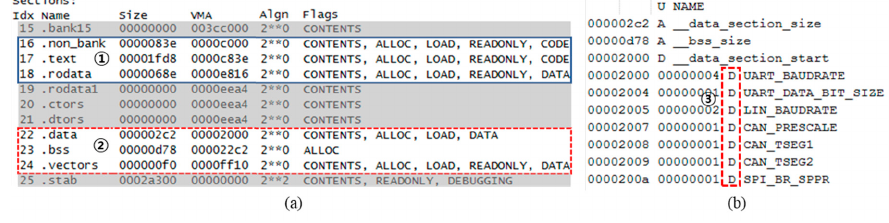
Figure 5. Memory section table and symbol List: ( a ) Memory section table; ( b ) Symbol